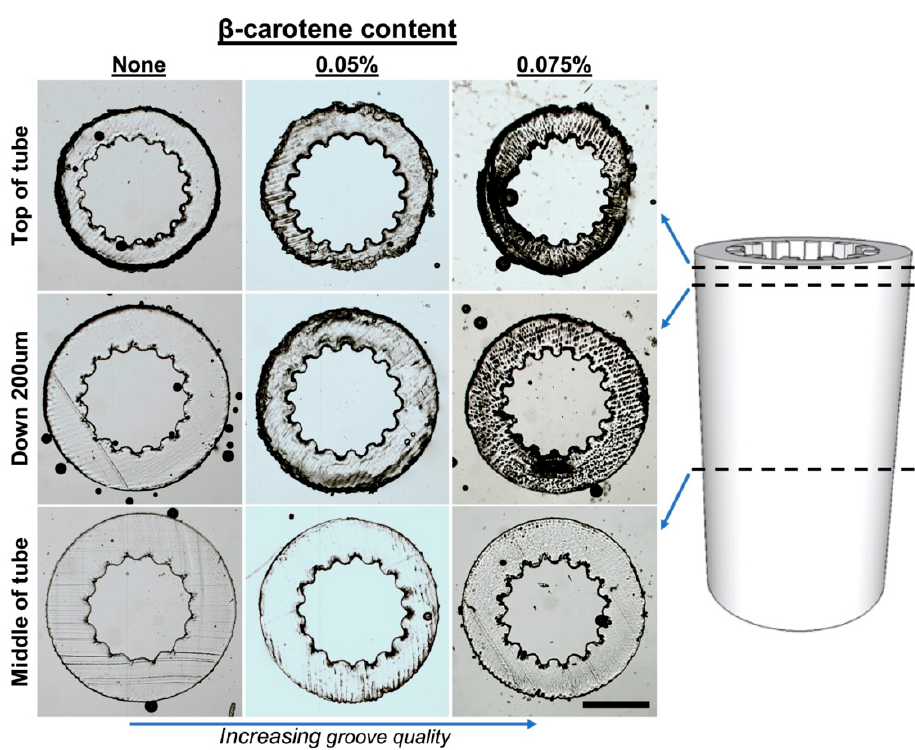
Figure 8. Demonstration of laser depth penetration control, and increased microstereolithography scaffold quality, with the addition of β‐ carotene in the PCLMA resin. Sections of grooved tubes (obtained using a cryostat) showing the appearance of the grooves down the length of the tubes. Groove quality decreases towards the middle of the tube but increases with an increasing amount of β‐ carotene in PCLMA resin. Scale bar: 500 μ m.